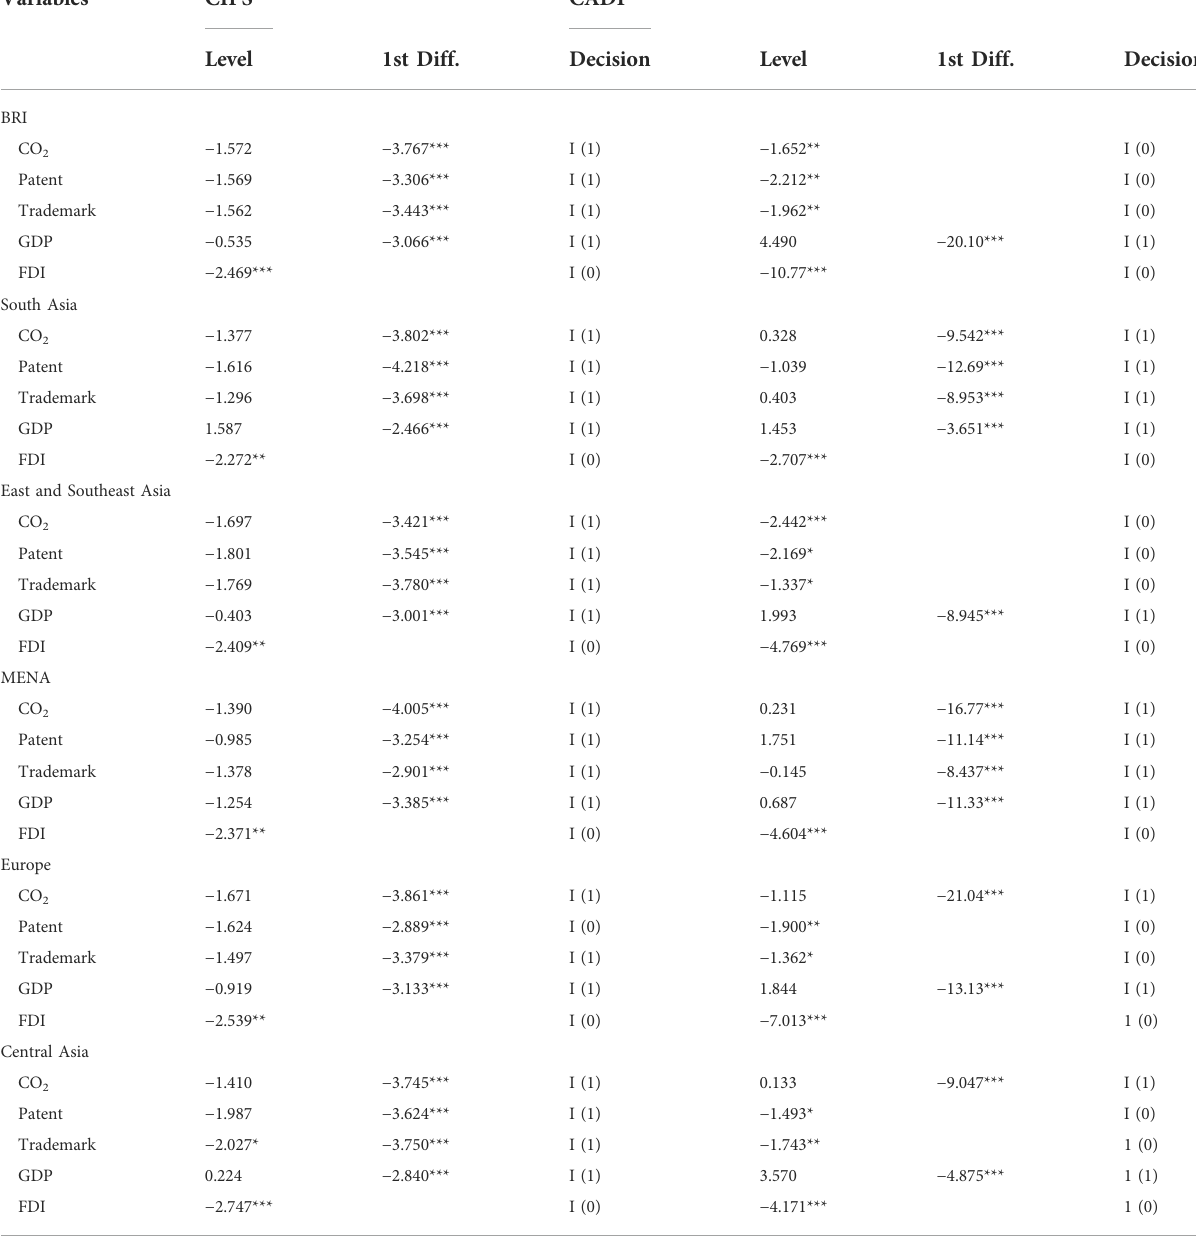
TABLE 5 Panel unit root